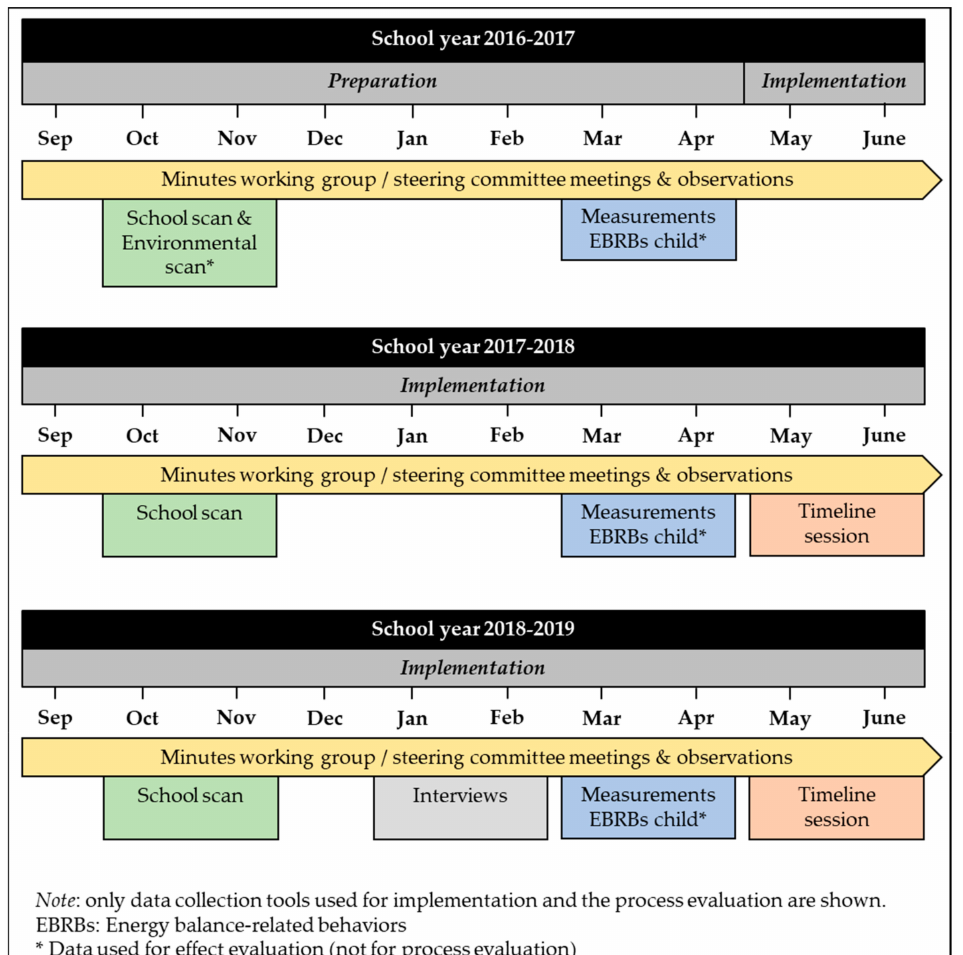
Figure 2. Timeline of data collection for process